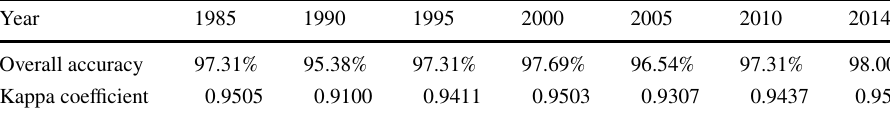
kappa coefficients of surface water extraction results